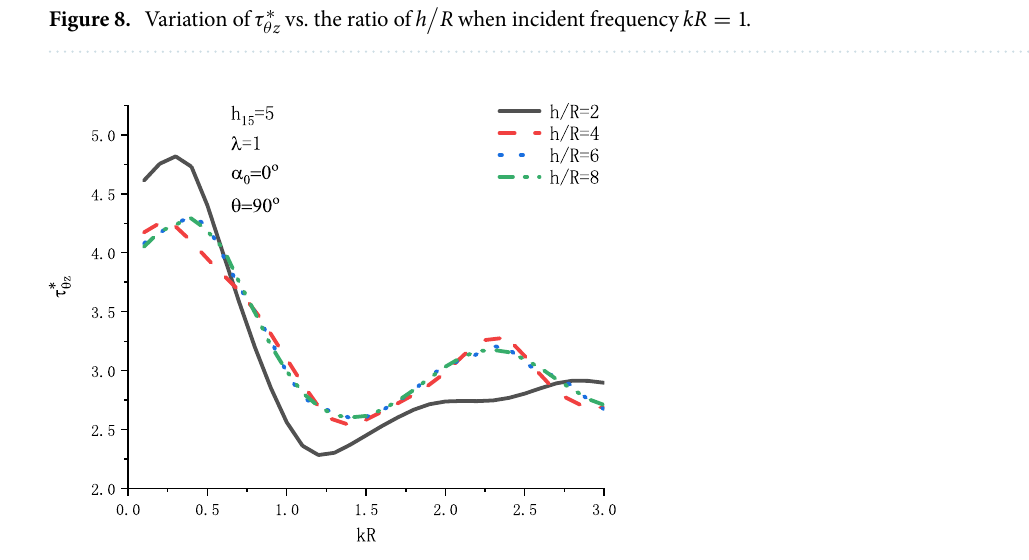
Figure 9. Variation of τ ∗ θ z vs. kR when SH wave incident